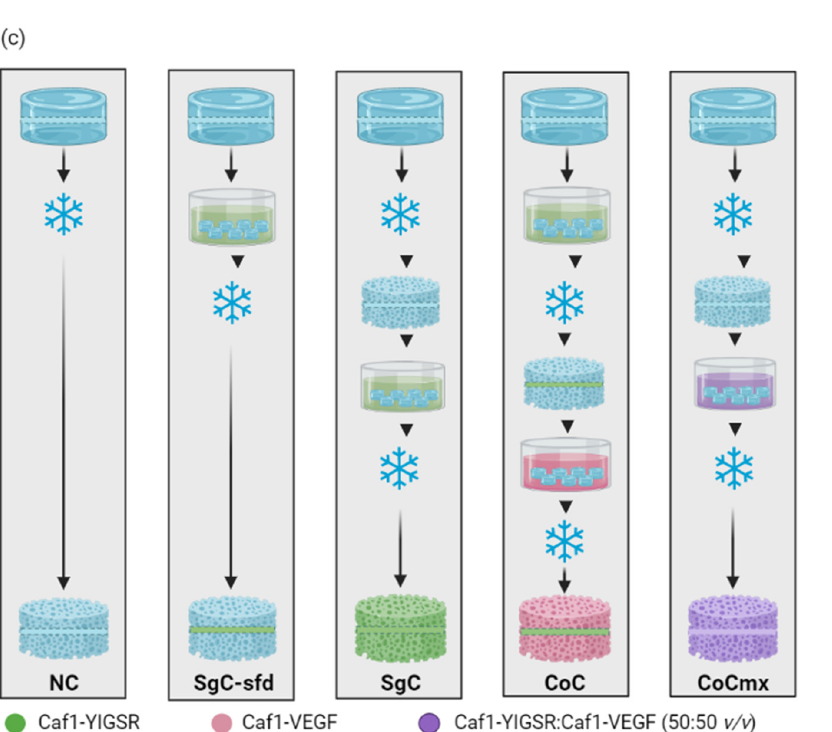
Figure 1. ( a ) Fabrication protocol of 3D porous hydrogels without coating; ( b ) Fabrication protocol of 3D porous hydrogels with coating (SFD: single freeze-drying; DFD: double freeze-drying); ( c ) Schematic plan of spatially controlled coating methods. NC: non-coated; SgC-sfd: single-coated-single-freeze-drying; SgC: single-coated; CoC: Co-coated; CoCmix: co ‐ coated ‐ co ‐ mixed.